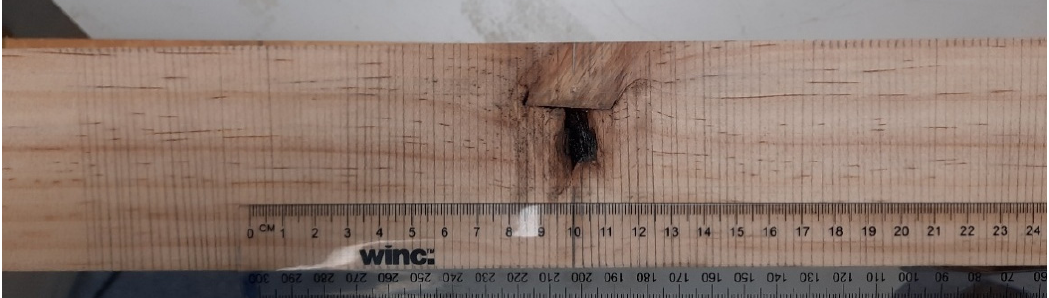
Figure 7. Surface expression of the branch mark on the pine wood surface.